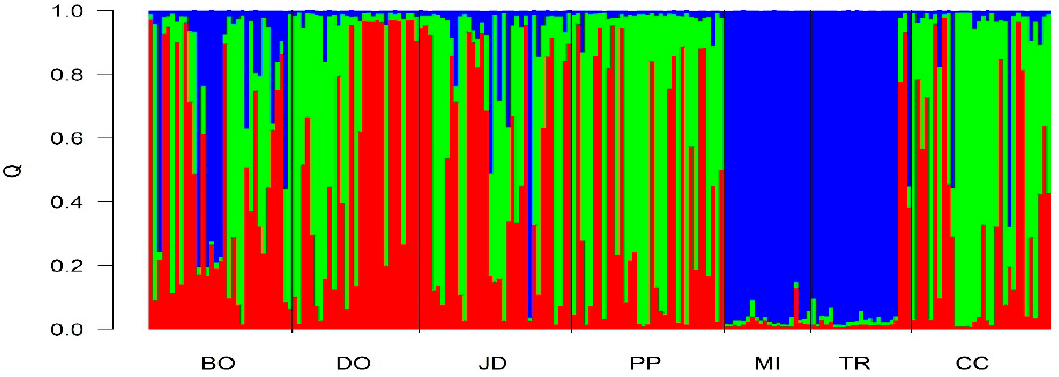
Figure 3. Individual grouping from seven different populations analyzed by the Bayesian statistical method using the STRUCTURE program. Each sample is represented by a vertical line divided into segments classified according to size and color. These results correspond to the relative proportion of the genome of Campomanesia adamantium concerning the population inferred by the program. Different populations are separated by black lines. Bonito/MS (BO); Dourados/MS (DO); Jardim/MS (JD); Ponta Porã/MS (PP); Mineiros/GO (MI); Três Ranchos/GO (TR); and Cerro Corá/AY (CC).